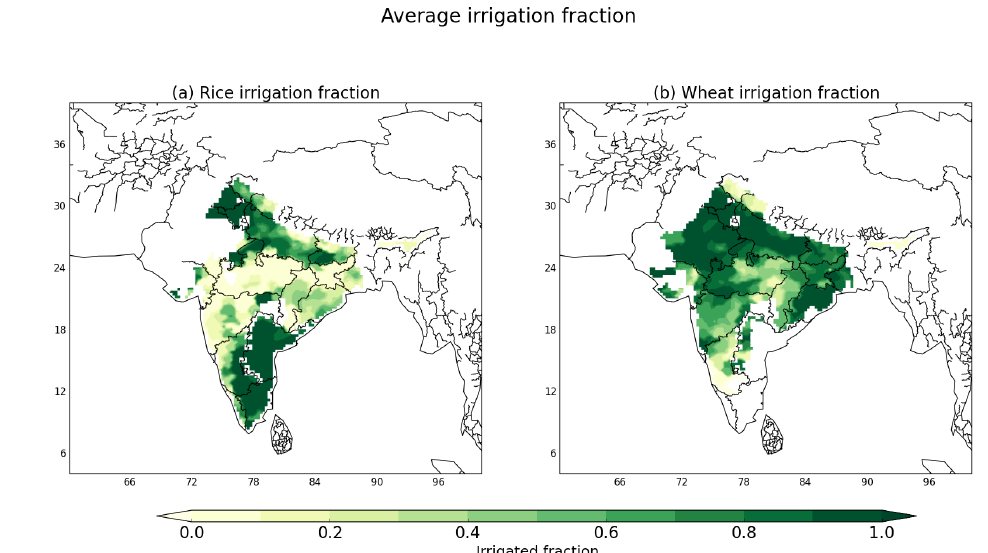
Figure 12. The average irrigation fraction for rice (a) and wheat (b) calculated from the ICRISAT observations of irrigation area and area